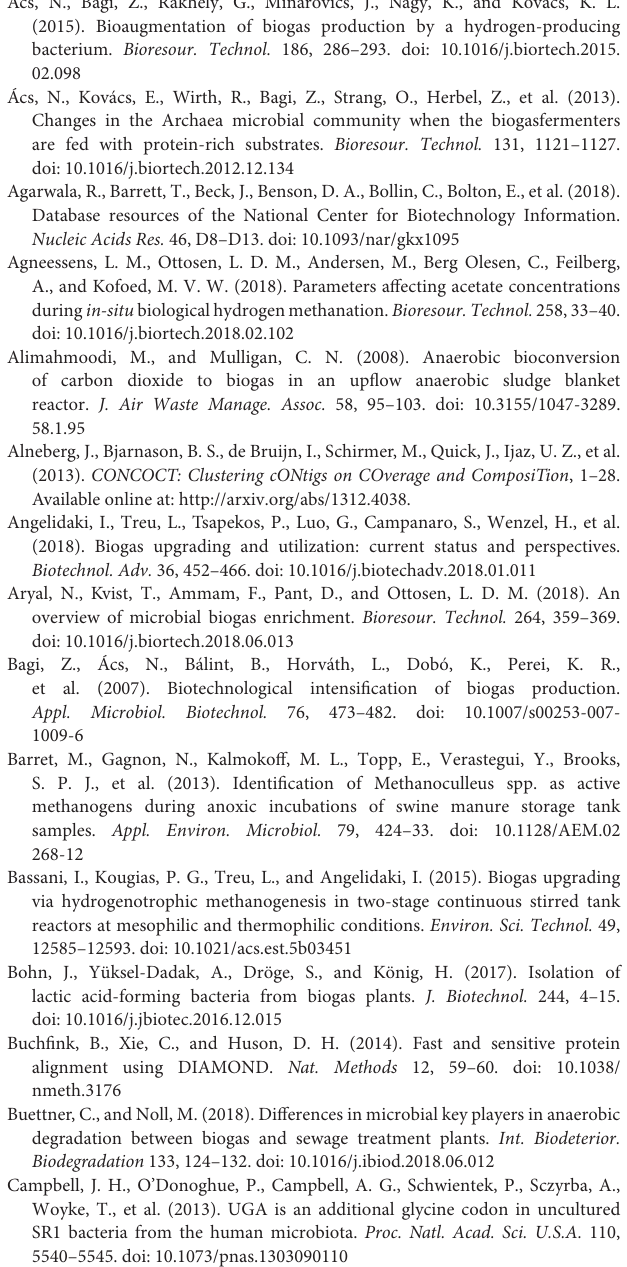
Supplementary Table 1A | Percentile changes in the abundances of Bacteria genera compared to the inoculum. Color codes are indicated at the top of the right-side column.